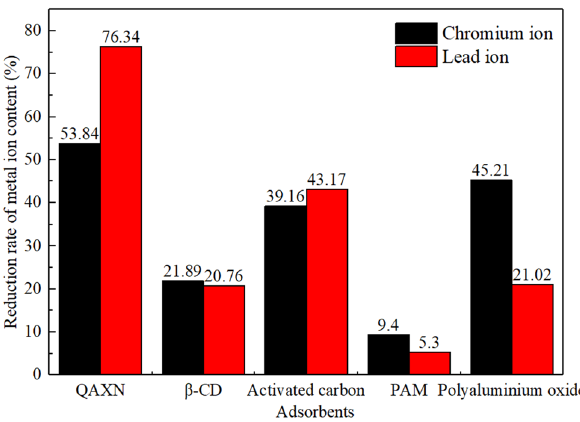
Figure 9: The in fl uence of di ff erent treatment agents on the content of metal ions in the waste water - based drilling fl uid fi